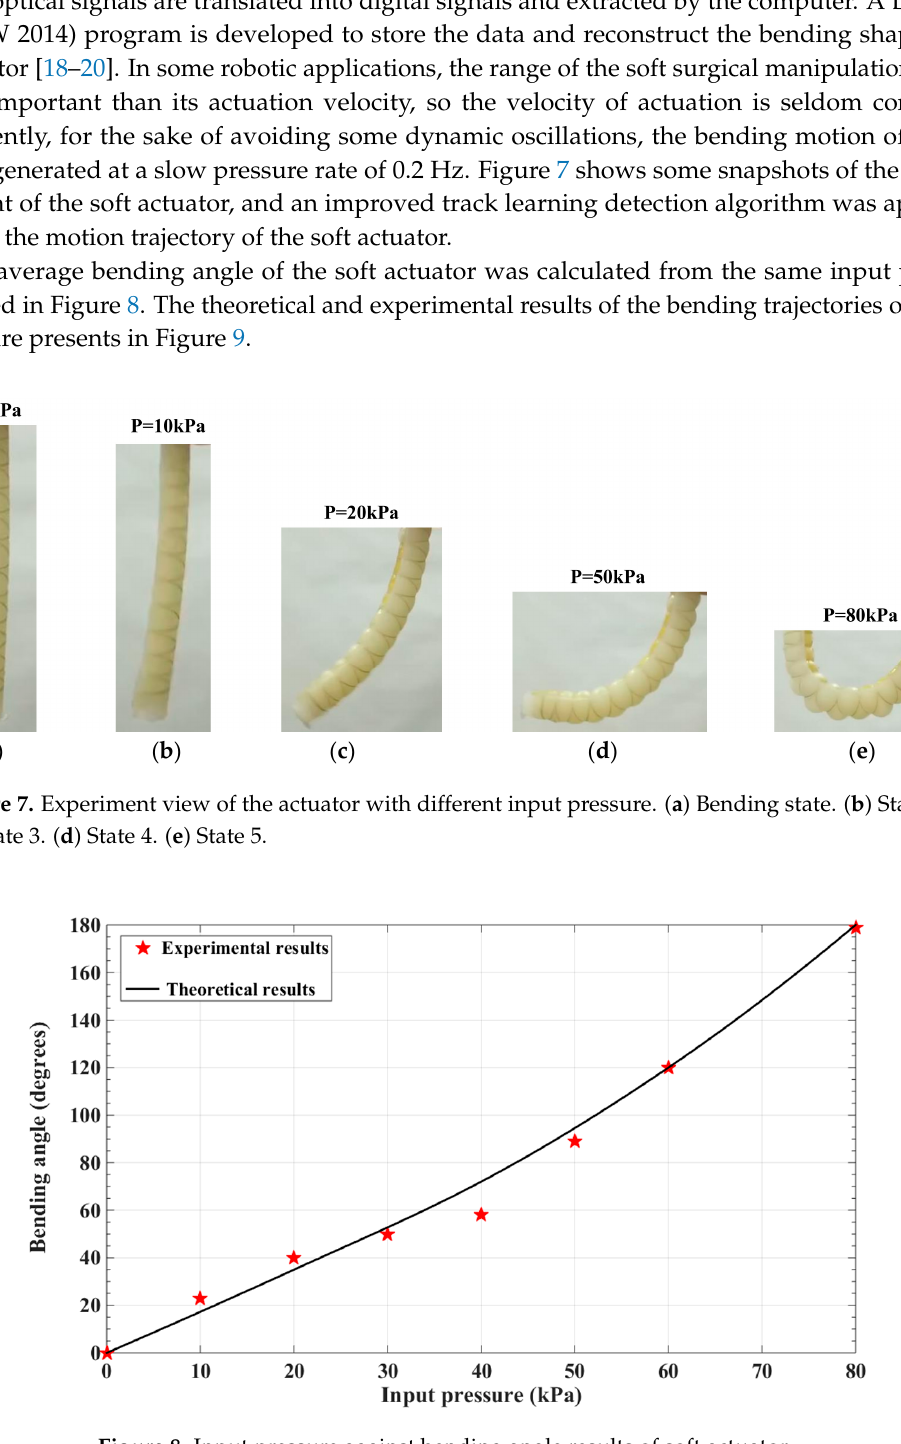
Figure 9. Motion trajectory of the actuator with different input pressure. 4.2. Shape Reconstruction of the Soft Actuator In order to demonstrate the effectiveness of the shape reconstruction method proposed in this paper, some bending experiments of the soft actuator based on embedded FBGs were carried out. The experimental setup is illustrated in Figure 10. In the experiment, the original center wavelengths of two FBGs (FBG1, FBG2) are 1544 nm and 1546 nm respectively. The peak reflectivity of the FBGs are 70% and the response time of the FBGs is 70 ms. Two FBG sensors are located in the intermediate axis of the soft actuator, and their relative positions as illustrated in Figure 4, Section 2. Figure 10. Experimental setup of the soft actuator with embedded FBGs.